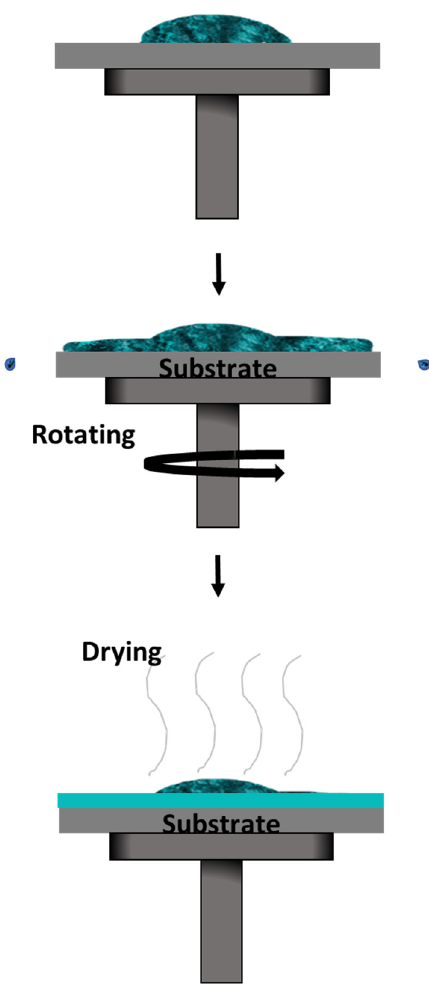
Figure 15. Spin coating method.